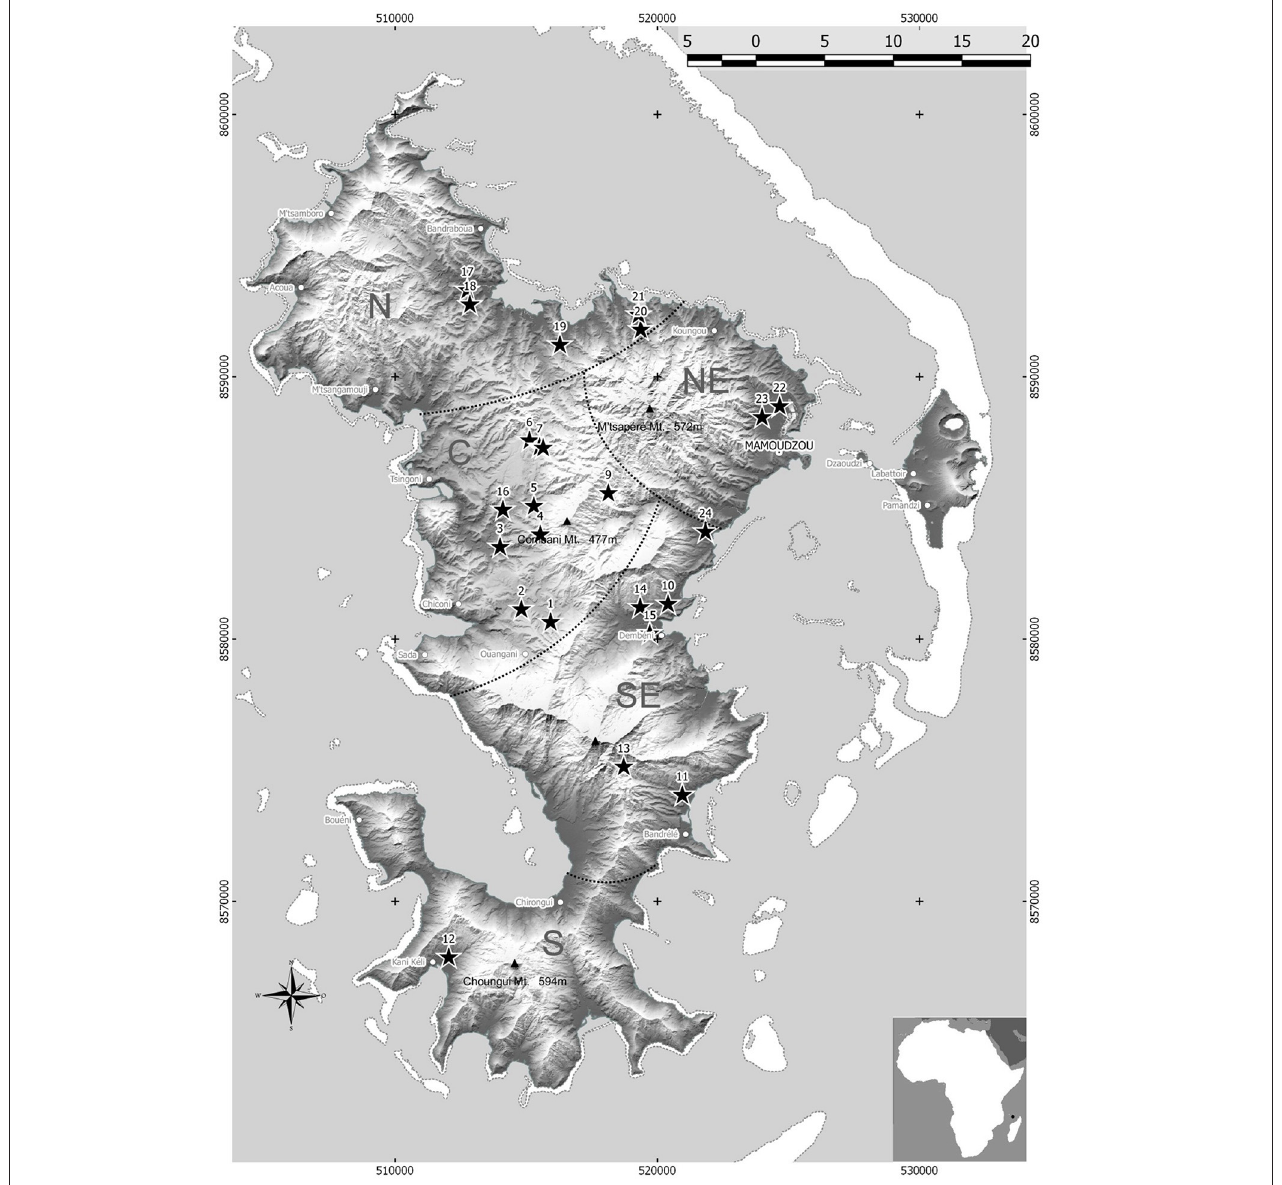
FIGURE 1 | Mayotte map showing the five main vegetable areas (C, Centre; N, North; NE, Northeast; S, South; SE, Southeast) and the 24 sites where phylotype I strain sequevars 31, 18, 46, and 15 were